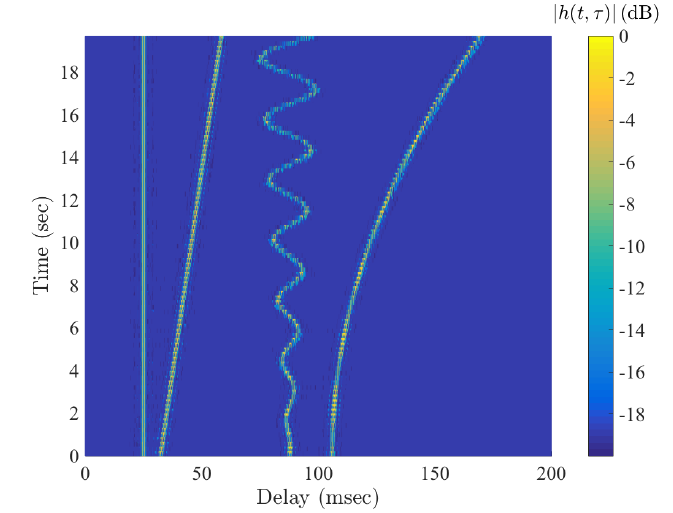
Figure 4. Examples of implementation of time-varying delay using